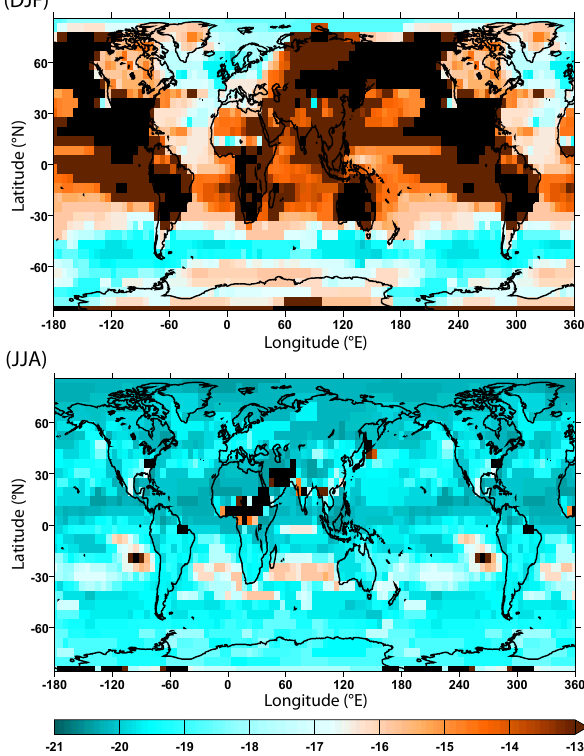
Fig. 7. Timing of first significant warming during the deglacia- tion from a 100 yr sample at 5% significance. DJF (top) and JJA (bottom). Color scale is the date inkyrs BP Black denotes regions without significant warming over the